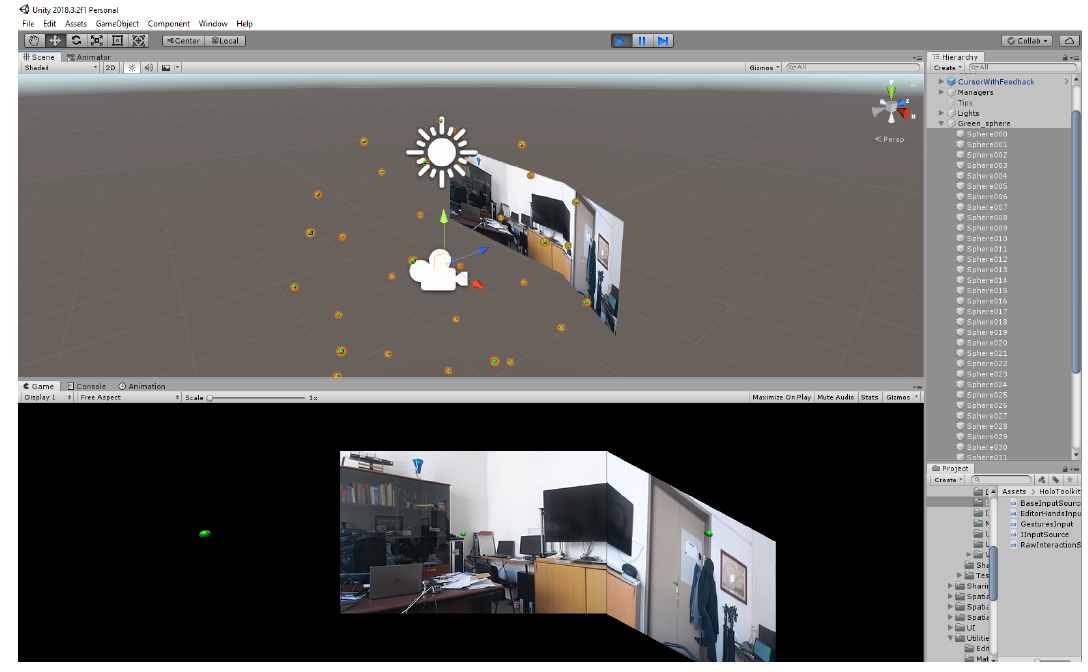
Figure 1. Spheremap creation in Unity pre-set